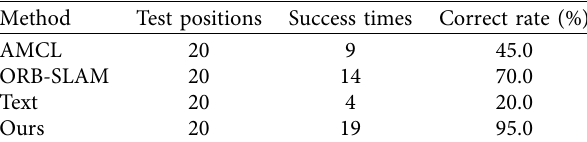
Figure 9: Lateral deviation.